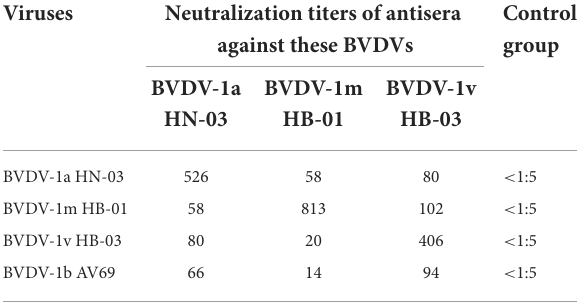
TABLE 4 Cross-neutralization titers of antisera against different strains of isolated bovine viral diarrhea virus (BVDV) genotypes. Viruses Neutralization titers of antisera Control against these BVDVs group